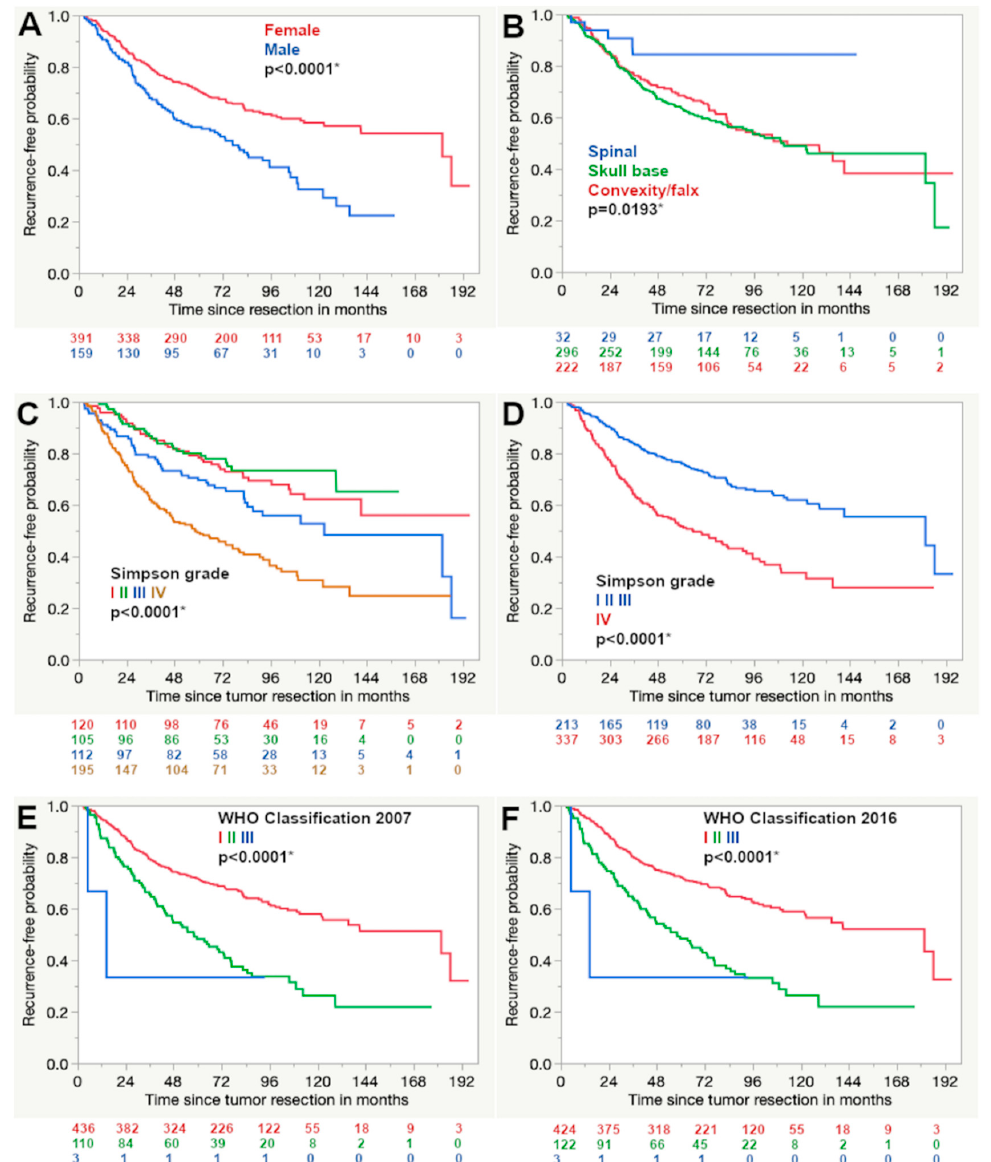
Figure 1. Kaplan–Meier curves show the results of the univariate survival analysis. A shorter progression-free survival was detected for male patients ( A ), non-spinal tumor location ( B ), higher Simpson ( C , D ) and WHO grade according to the classifications of 2007 and 2016 ( E , F , respectively) (Log rank test, asterisk (*): statistically significant result).